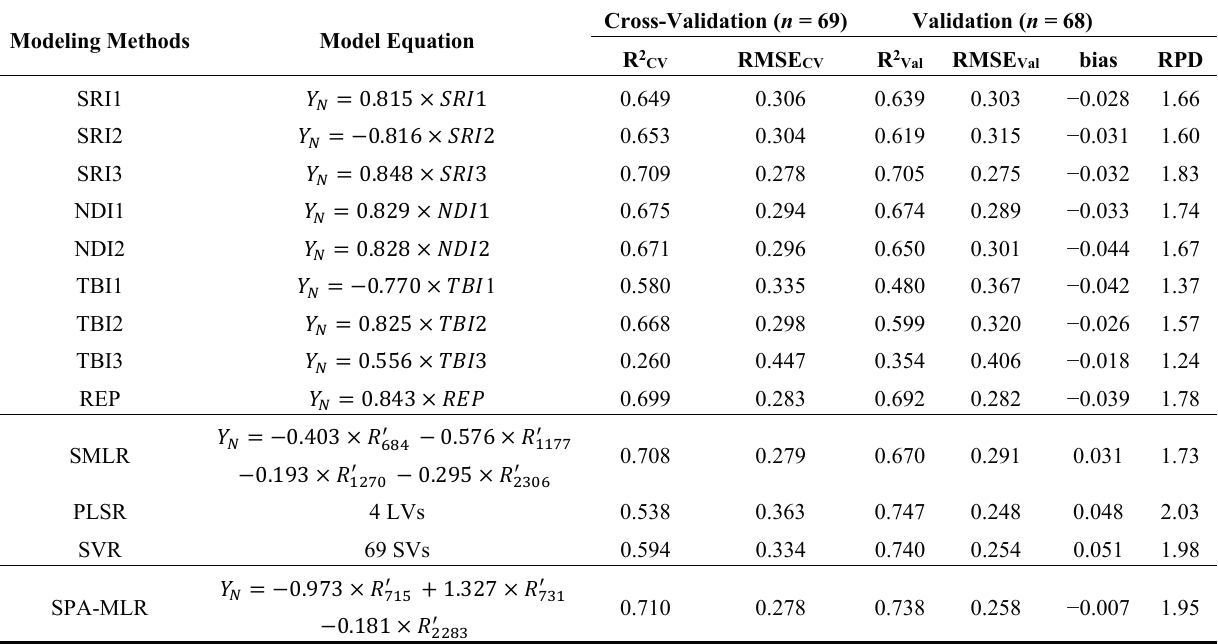
Table 4. Cross-validation and validation results of 13 modeling methods to estimate N contents at the canopy level. SPA, successive projections algorithm.